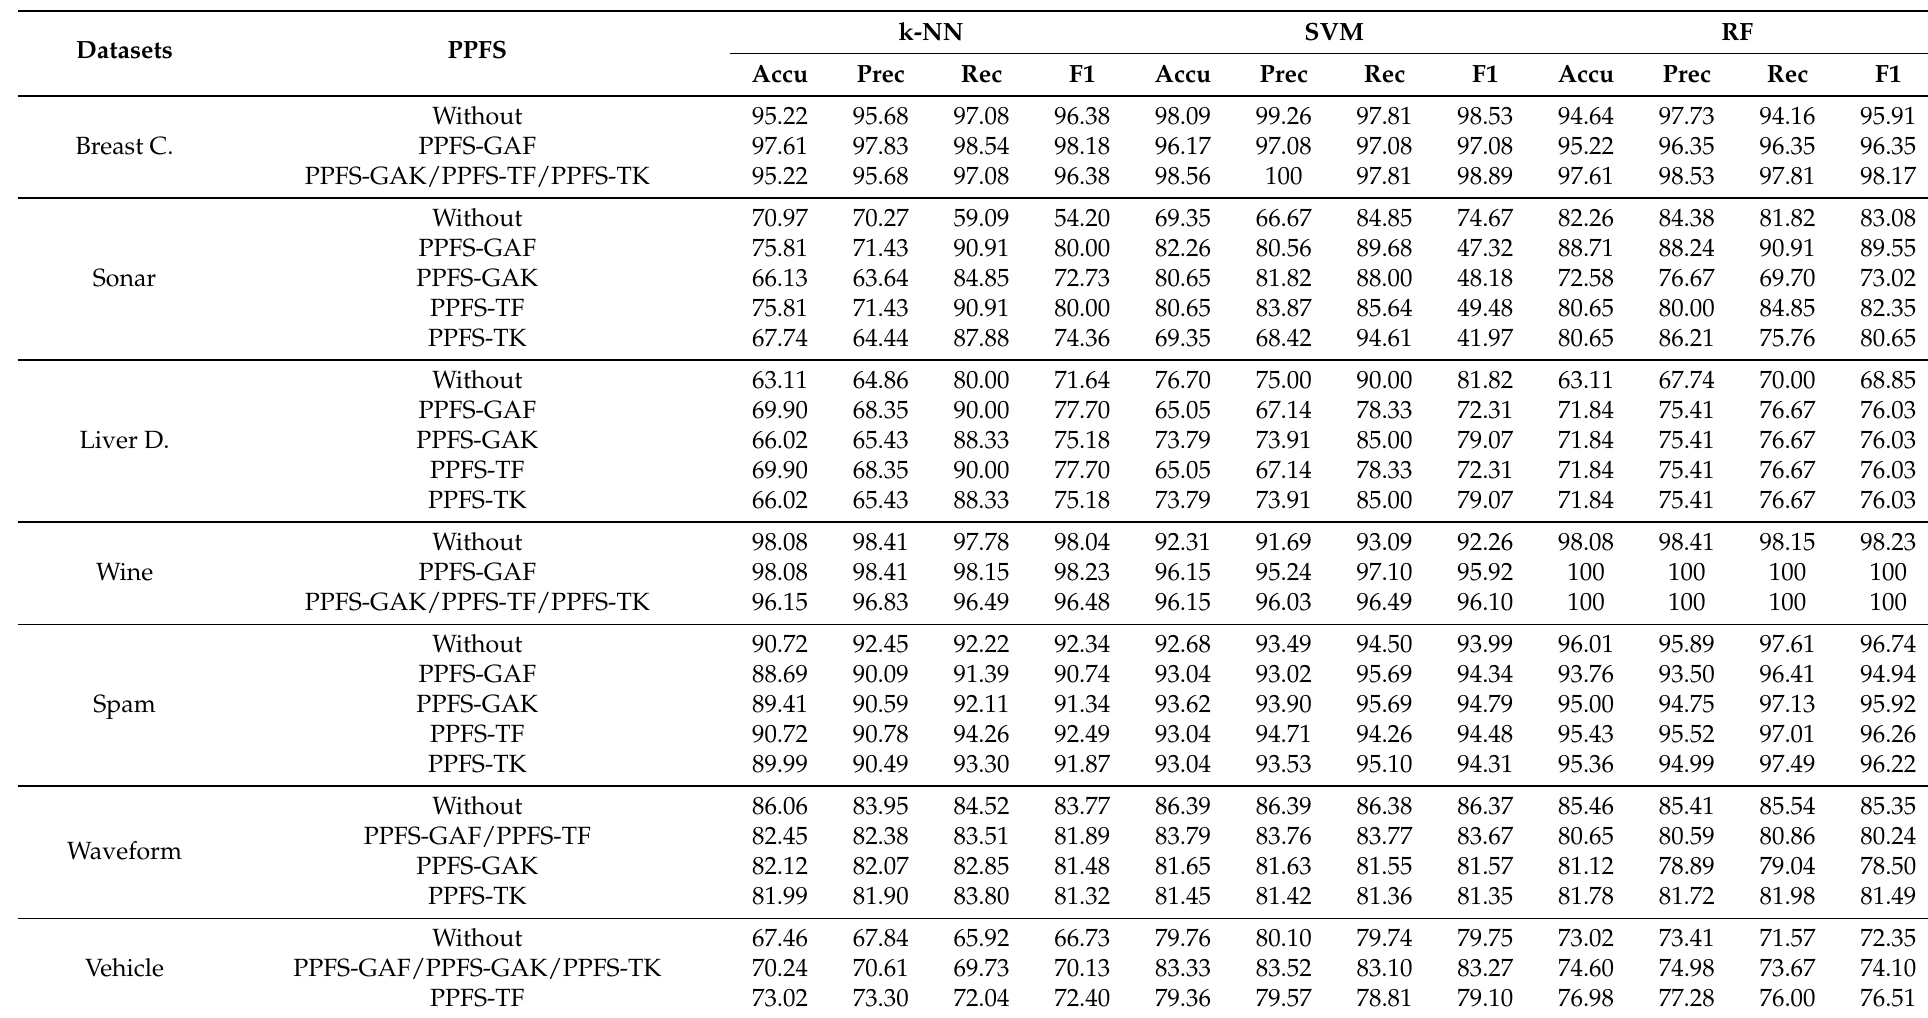
Table 6. The classification results obtained after (and before) applying the PPFS approaches using KNN, SVM, and RF classifiers for the 19 datasets. Datasets